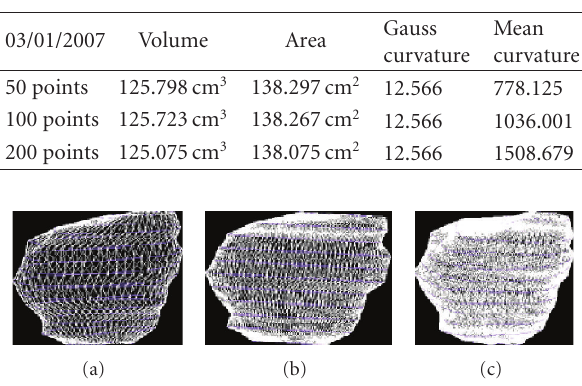
Figure 29: Patient 3. (a) 50 points on the contours, (b) 100 points on the contours, and (c) 200 points on the contours.